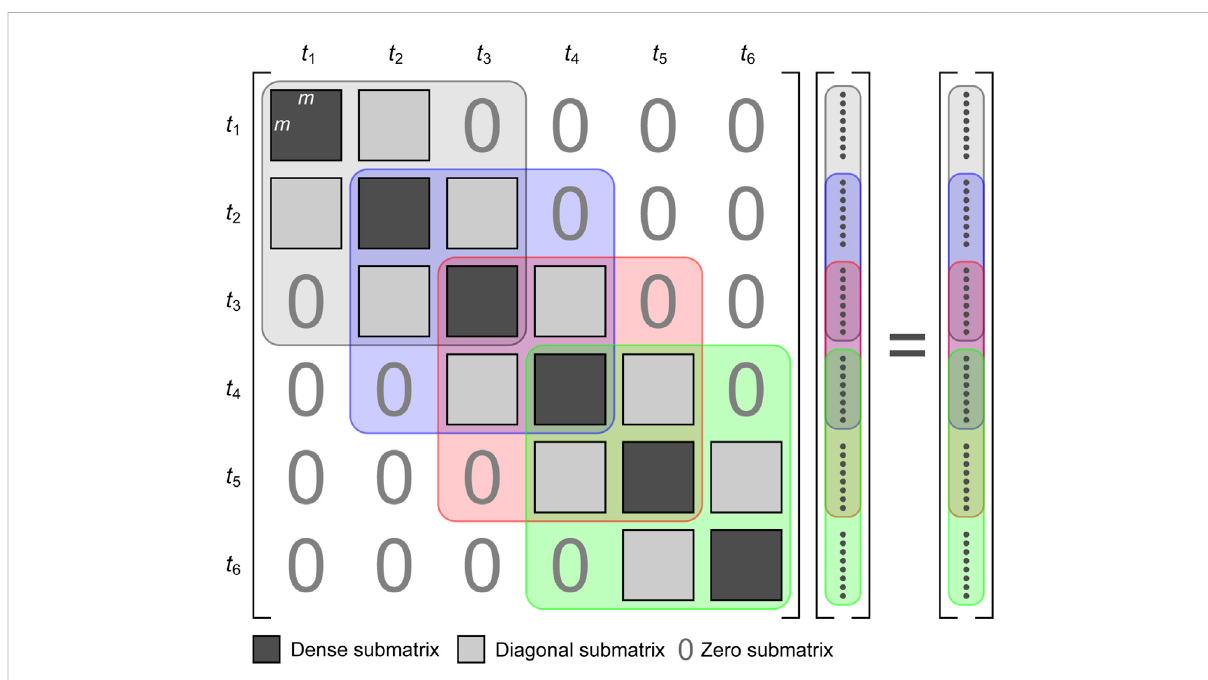
FIGURE 1 Structure of matrix Eq. 1 for solution of the full sequence 4D inversion. Grey, blue, red and green coloured outlines highlight the subproblems solved in sequential windowed 4D inversions, with a window length of three